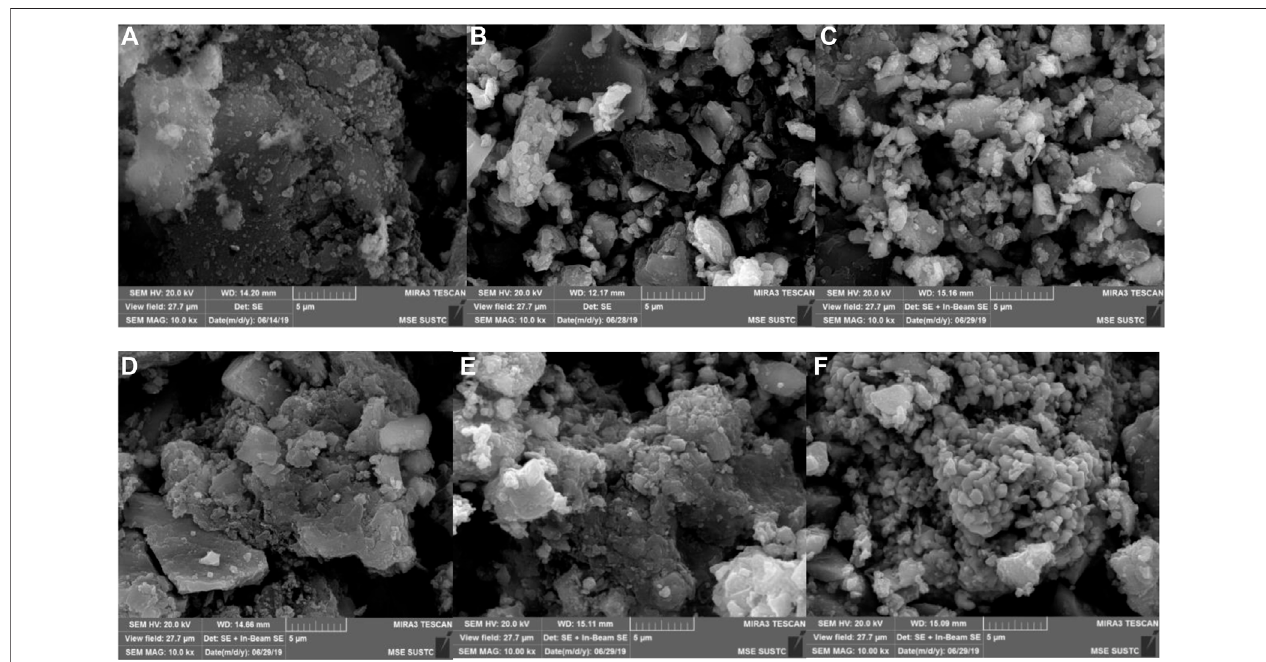
FIGURE4| SEMimagesofvariousstagesofpyrolysisofsludgeandsteelslag: (A) DS, (B) 300 ° CSS, (C) 400 ° CSS, (D) 500 ° CSS, (E) 600 ° CSS,and (F) 700 ° CSS.